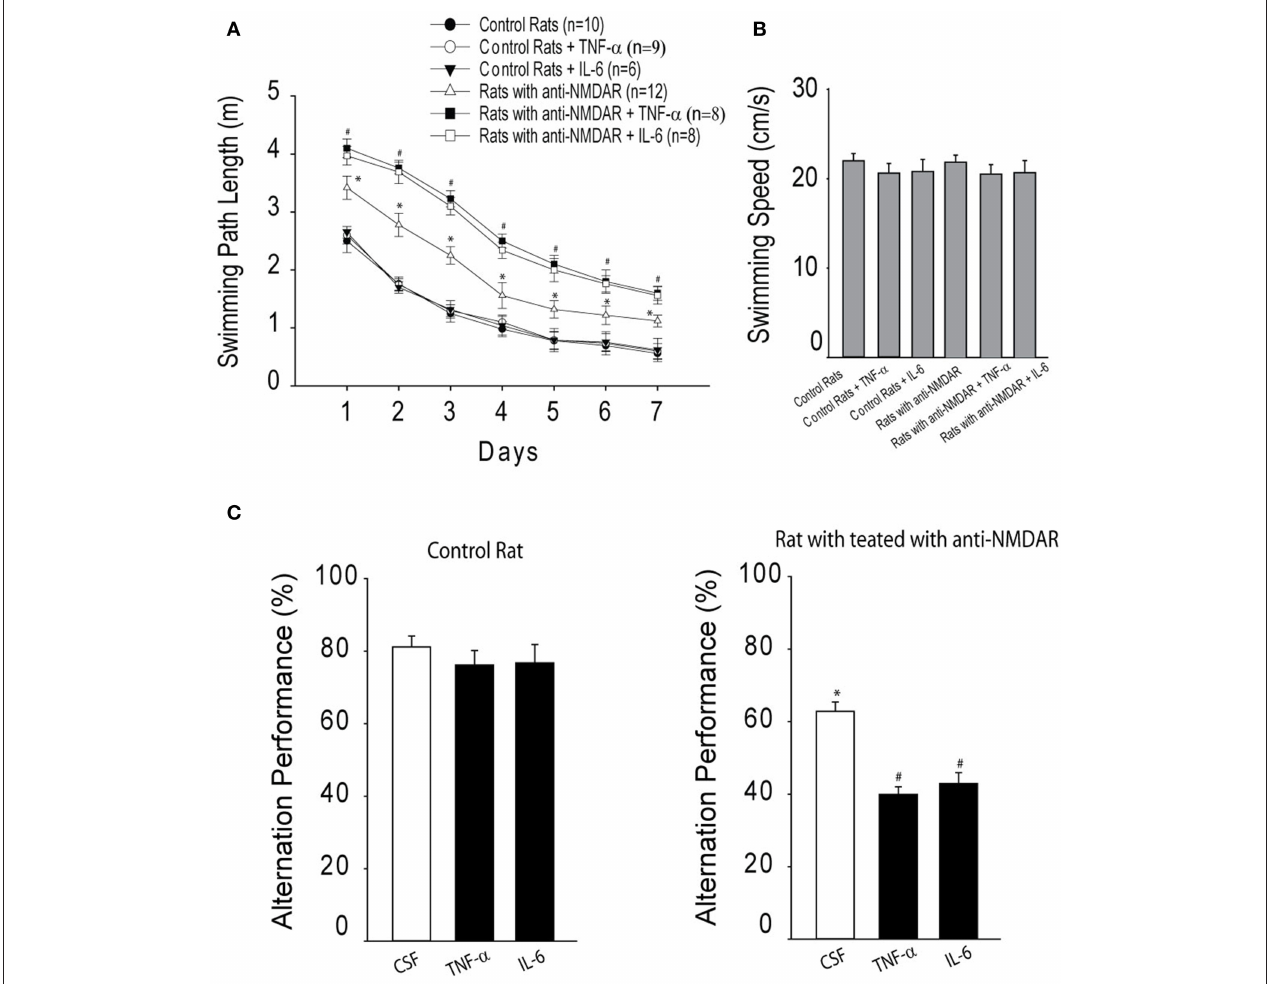
FIGURE 3 | (A) The cumulative swimming path length on 7 consecutive days in the Morris water maze for six experimental groups, showing increases of swimming path length in rats that have been injected with anti-NMDAR as compared to control rats. TNF- α or IL-6 amplified increases of swimming path length observed in rats anti-NMDAR, but not in control rats. * P < 0.05 vs. control rats; and # P < 0.05, TNF- α /IL-6 vs. CSF control. (B) There were insignificant differences observed in the swimming speed in these different experimental groups ( P > 0.05). (C) The effects of anti-NMDAR on spontaneous alternation performance in rats. The learning performance was examined after infusion of TNF- α or IL-6. * P < 0.05, control rats vs. rats treated with anti-NMDAR. # P < 0.05, TNF- α /IL-6 vs. CSF control. The number of animals in each group is shown in the